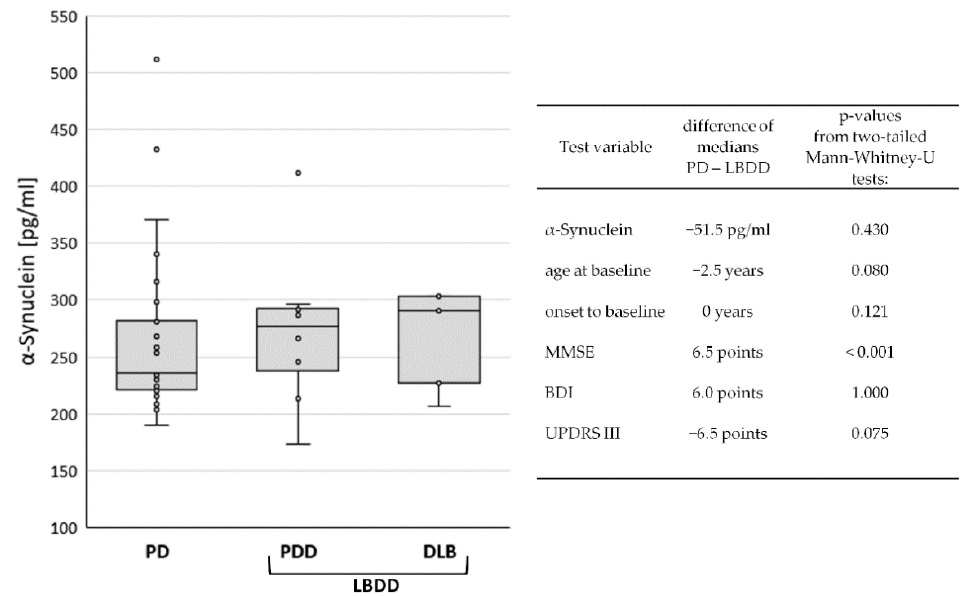
Figure 1. Comparison of baseline data between diagnostic groups. Box Plot of CSF α -synuclein levels in Parkinson’s disease (PD), Parkinson’s disease dementia (PDD), and dementia with Lewy bodies (DLB), left panel. In the right panel, differences in mean values and p -values from group comparisons between PD and Lewy body disease with dementia (LBDD) are displayed.